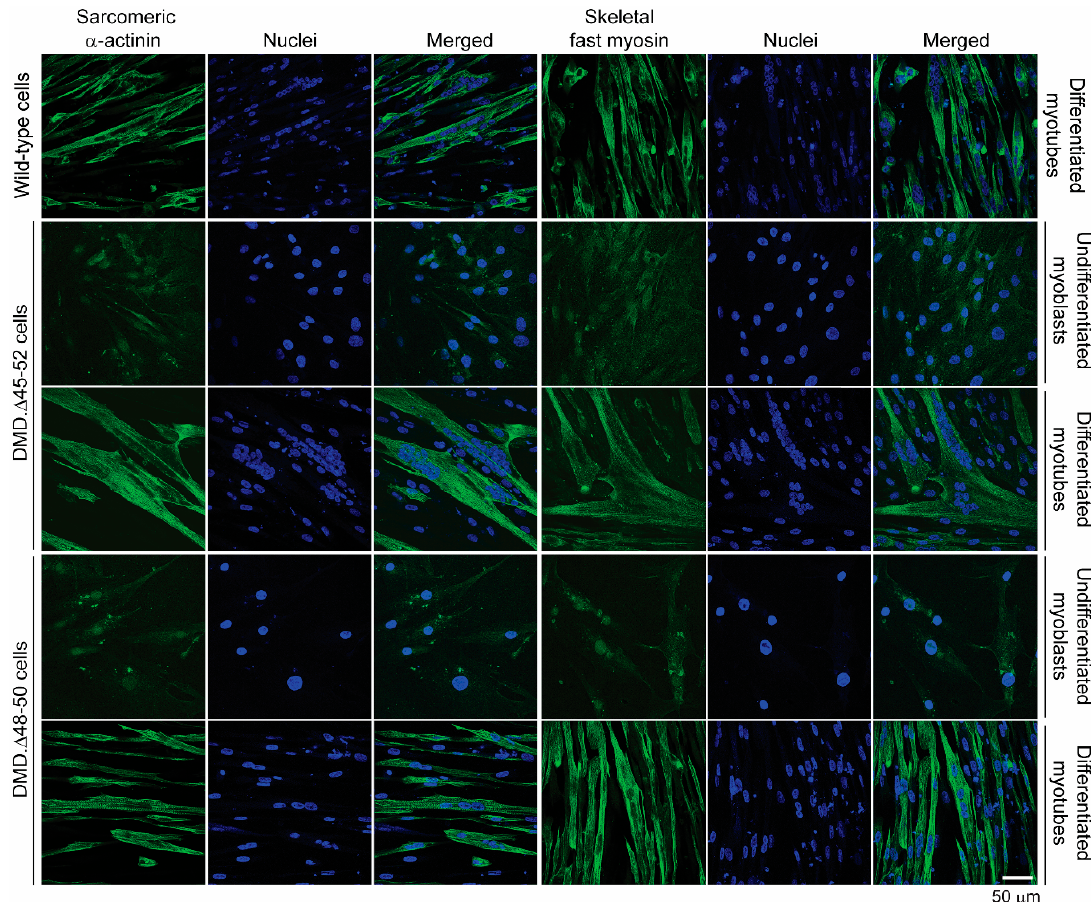
Figure 6. Assessment of the di ff erentiation capacity of DMD myoblasts transduced with DMD -editing HC-AdV particles. DMD. ∆ 45–52 and DMD. ∆ 48–50 myoblasts were transduced with CD46-targeting HC-AdV.eCas9 gIN43.gIN54 particles at an MOI of 500 genome copies per cell (GC cell − 1 ). Sarcomeric α -actinin and skeletal fast myosin immunofluorescence microscopy analyses were performed before and after myoblasts di ff erentiation at 3 days and 8 days post-transduction, respectively. Nuclei were labeled with the DNA dye DAPI. Mock-transduced wild-type human myotubes served as positive controls for the detection of the skeletal muscle di ff erentiation markers sarcomeric α -actinin and skeletal fast